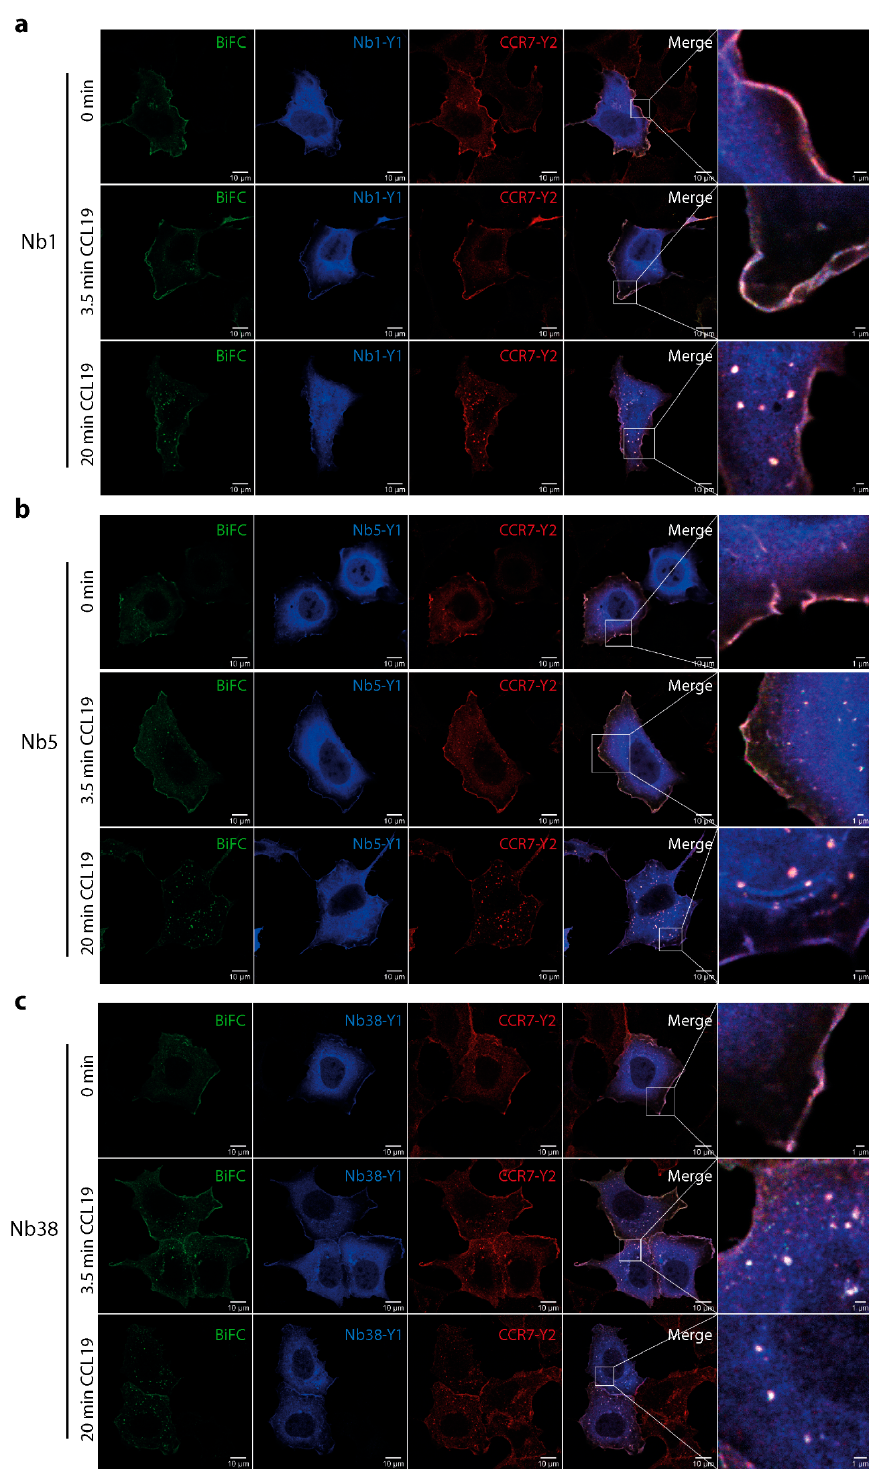
Figure 6. Monitoring CCR7 tra ffi cking triggered by CCL19 using Nb1, Nb5, and Nb38. Interaction between CCR7-YFP2 (Y2) and individual Nbs fused to YFP1 was assessed by BiFC and confocal microscopy in HEK293 transfected cells that were unstimulated or stimulated for indicated time points with 0.5 µ g / mL of CCL19. Nb1-YFP1 (Y1) ( a ), Nb5-YFP1 (Y1) ( b ), and Nb38-YFP1 (Y1) ( c ). In addition, Nb-Y1 and CCR7-Y2 were immunostained using anti-YFP1 and anti-YFP2 specific antibodies. Scale bar: 10 µ m, zoomed image: 1 µ